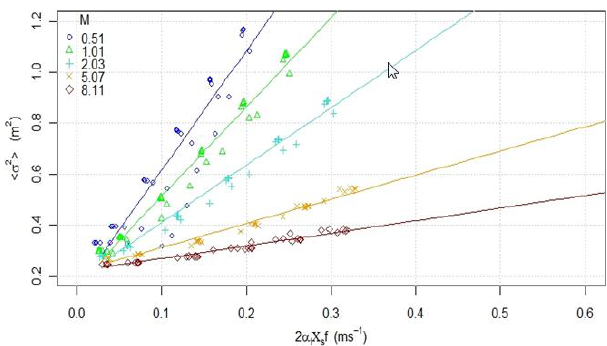
Fig. 8. Relation between the average variance of the mixing